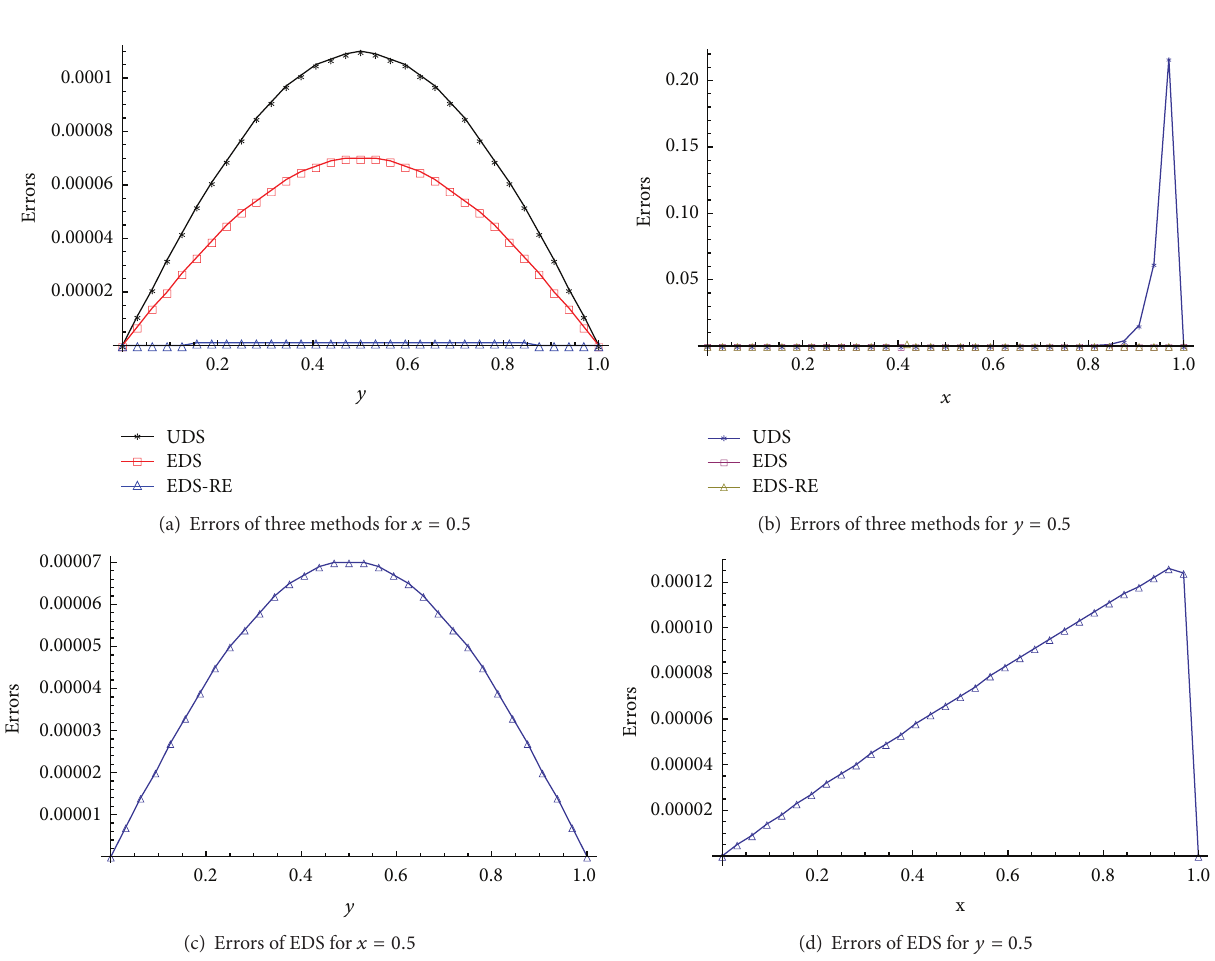
(d) Errors of EDS for 𝑦 = 0.5